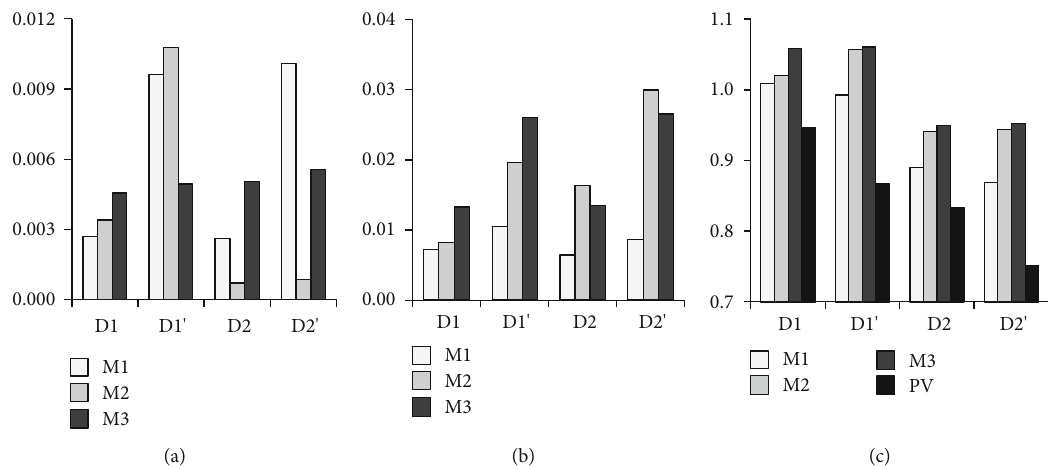
Figure 5: Daily mean values of the exergy e ffi ciency of heat production (a), improvement of photovoltaic e ffi ciency (b), and total normalized e ffi ciency (c) of PV/T in di ff erent modes: 1, M1; 2, M2; 3, M3; 4,